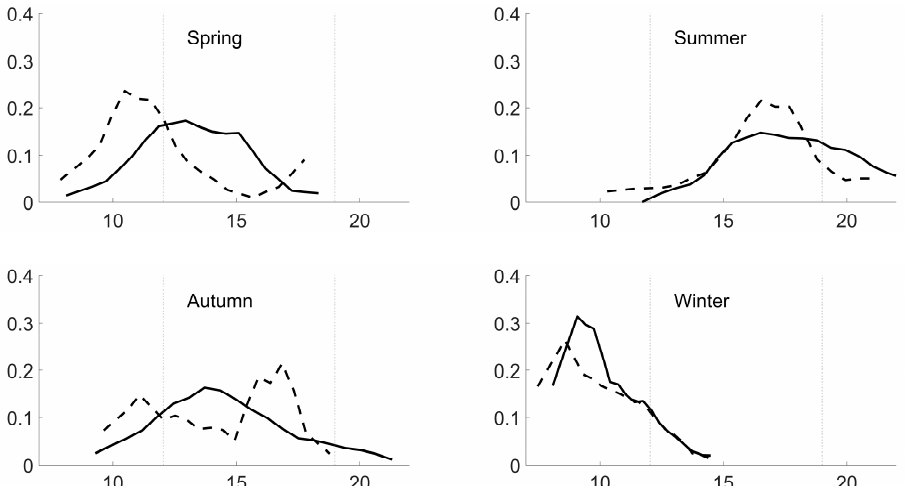
Figure 6. A comparison of the frequency distribution of water level for four seasons between the two periods. The solid lines represent the frequency distribution of the water level of the years in the early period, the and dashed lines represent the frequency distribution in the latter period. The two vertical lines on the left and right represent the minimum ecological water level [62] and the warning water level, respectively.